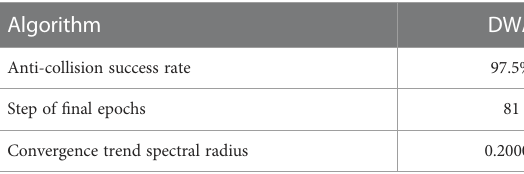
TABLE 4 The result data of different